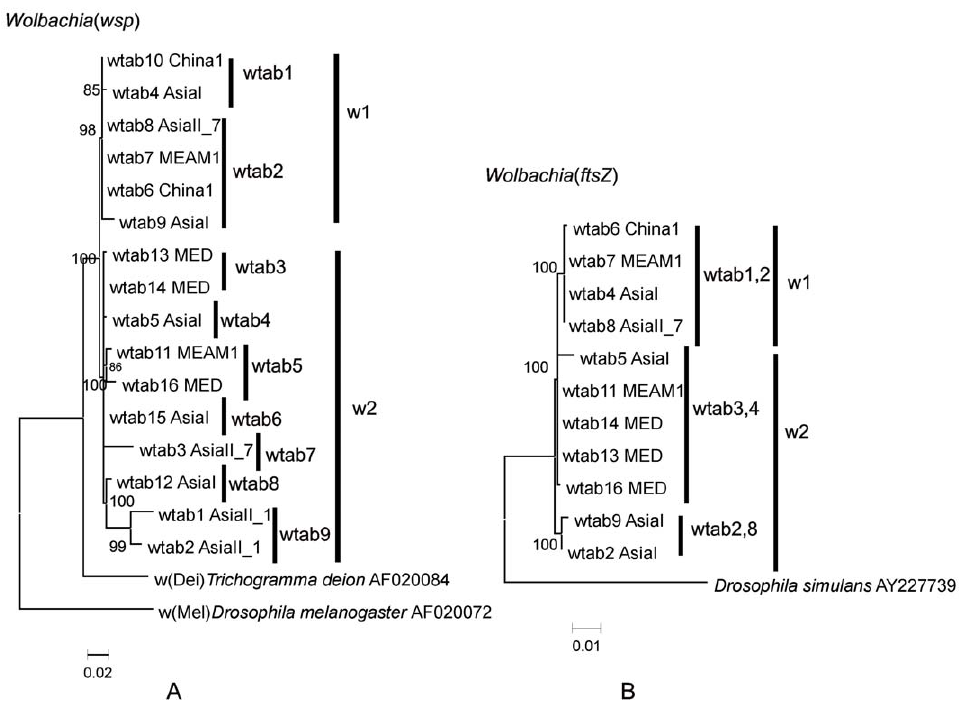
Figure 2. Phylogenies of the S-endosymbiont Wolbachia . A. Phylogenetic tree reconstruction based on wsp gene sequences (length=480 bp) of Wolbachia of B. tabaci cryptic species using maximum-likelihood analysis under the T92 substitution model. The bootstrap values are indicated. Trichogramma deion (AF020084) and Drosophila melanogaster (AF020072) are used as outgroups. Accession numbers for wtab1-16 submitted to GenBank are JX428697–JX428712. All wsp sequences of Wolbachia used in this study were clustered with other blast references sequences from GenBank and their ML phylogenetic reconstruction is shown Fig. C. B. Phylogenetic tree reconstruction based on ftsZ gene sequences (length=850) of Wolbachia of B. tabaci cryptic species using ML analysis under the TN93 substitution model. The bootstrap values are indicated. Drosophila simulans in case of ftsZ gene (AY227739) is used as the outgroup. Accession numbers for sequences used in the tree are JX428732–JX428742. All ftsZ sequences of Wolbachia used in this study were clustered with other blast references sequences from GenBank and their ML phylogenetic reconstruction is shown Fig. S1D.